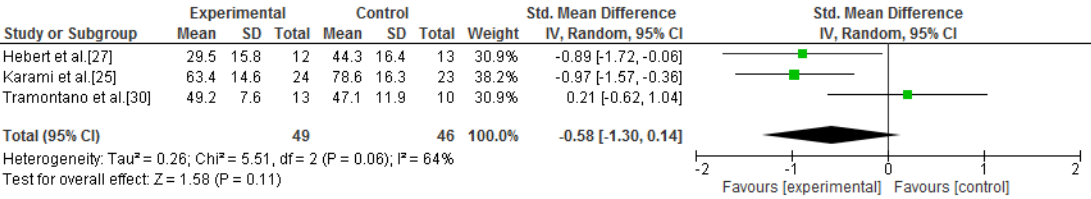
Figure 7. Forest plot of the meta-analysis of fatigue (vestibular rehabilitation versus other exercises).